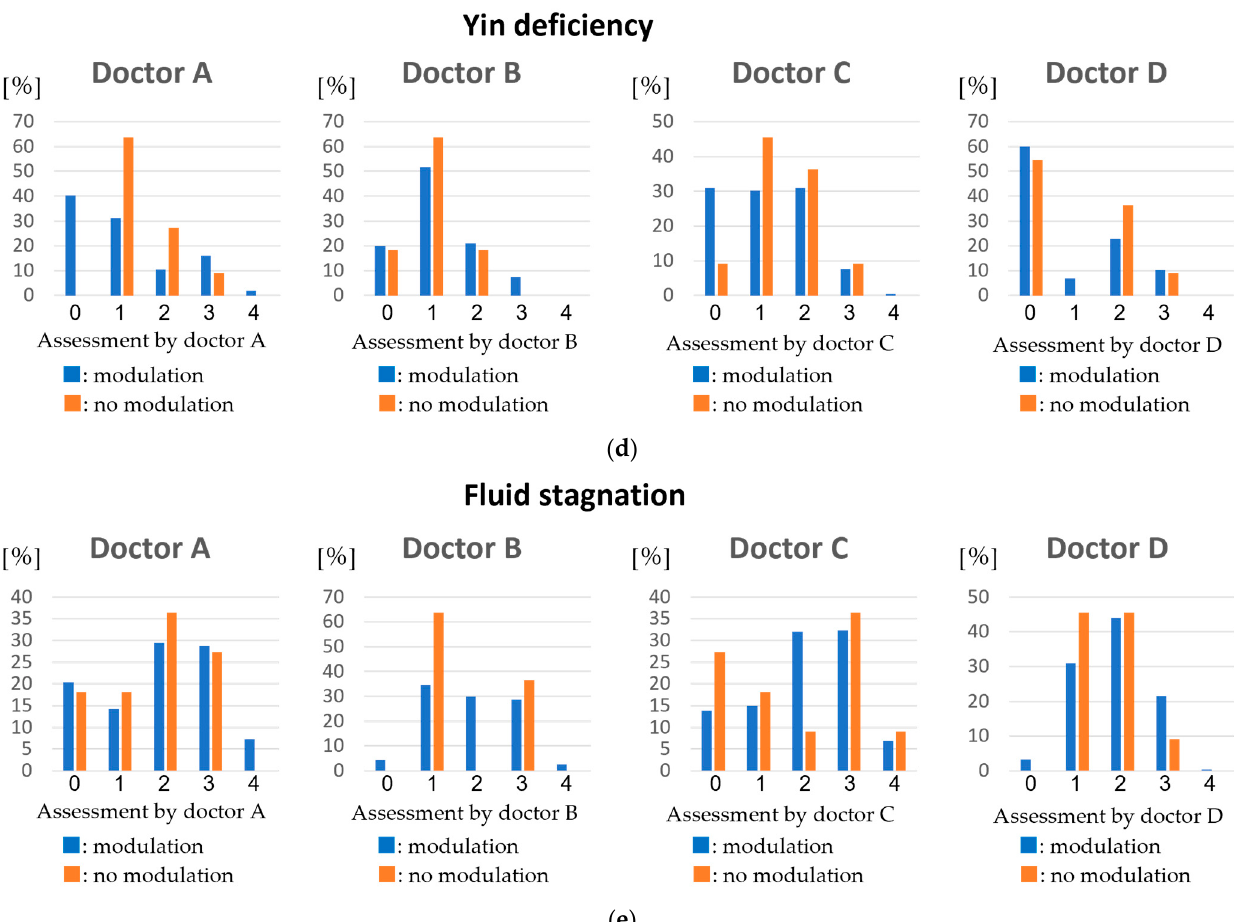
Figure 7. Percentage of values evaluated by each of the four Kampo doctors (A, B, C, and D) for each disease after data modulation (blue bars), and without data modulation (orange bars): ( a ) Percentage of each correct value for qi deficiency; ( b ) Percentage of each correct value for blood deficiency; ( c ) Percentage of each correct value for blood stagnation; ( d ) Percentage of each correct value for yin deficiency; ( e ) Percentage of each correct value for fluid stagnation.